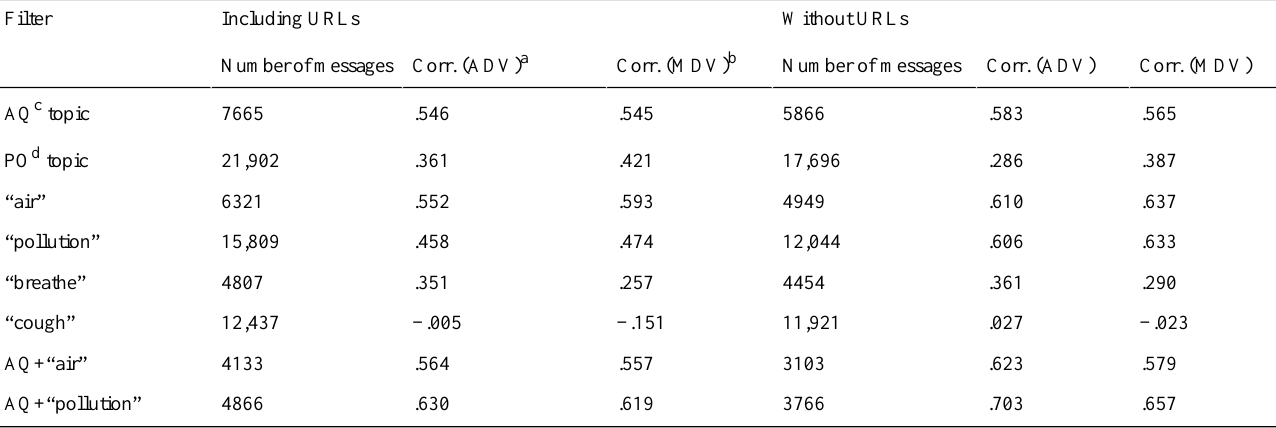
Table 1. Correlation of messages matching each filter in 74 cities to the average (ADV) and maximum (MDV) daily PM2.5 values in 2013.